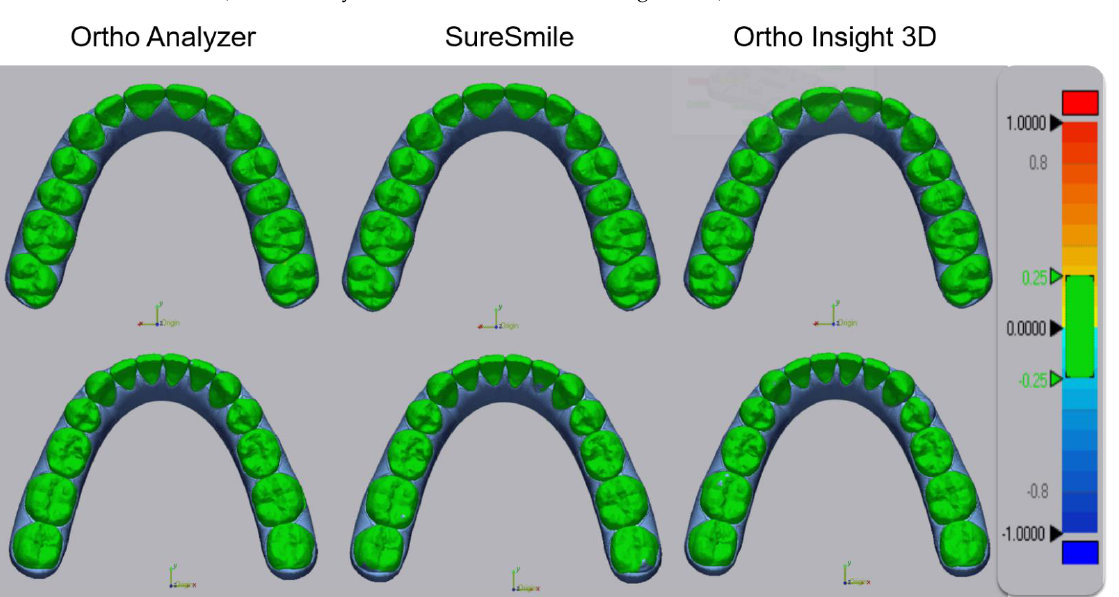
Figure 2. Color-coded maps outside the tolerance. Reference STL (ClinCheck ® Pro). Target STL (Ortho Analyzer ® , SureSmile ® , Ortho Insight 3D ® ).